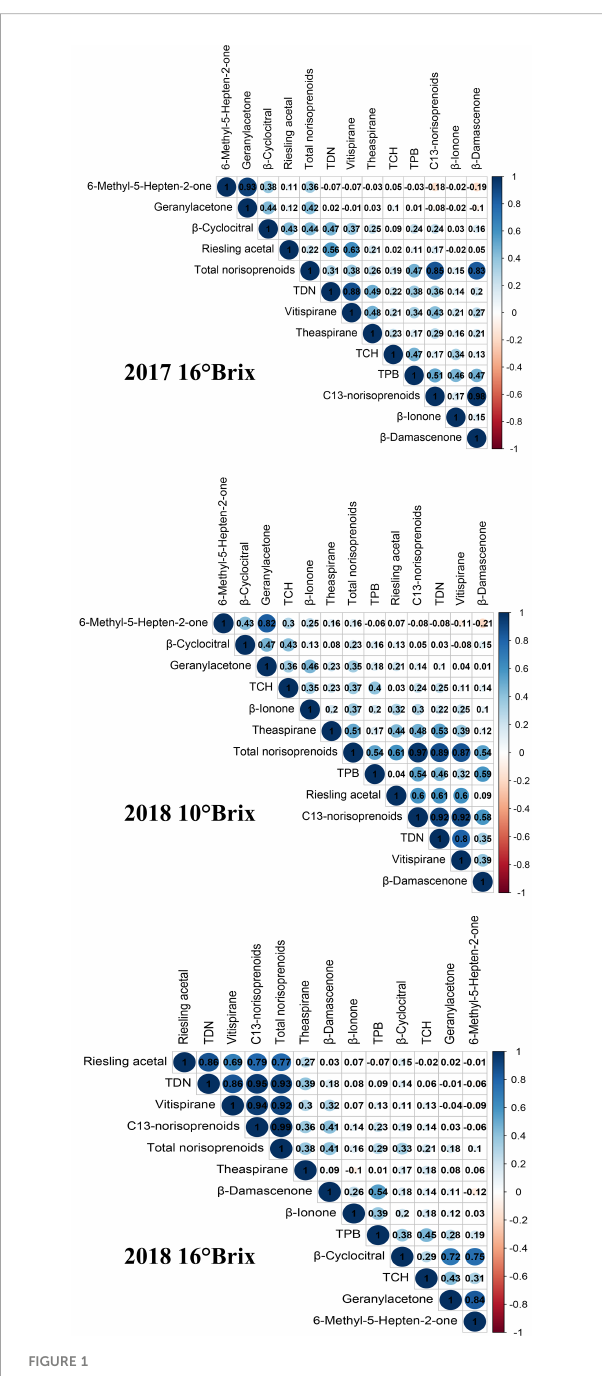
FIGURE 1 Correlations among the concentrations of various norisoprenoid compounds in the F 1 population at three sampling periods. The numbers in the graph are correlation coef fi cients, and the signi fi cant correlation ( p < 0.01) are highlighted with colored circles (blue and red). The color intensity of the circle also indicates the strength of the